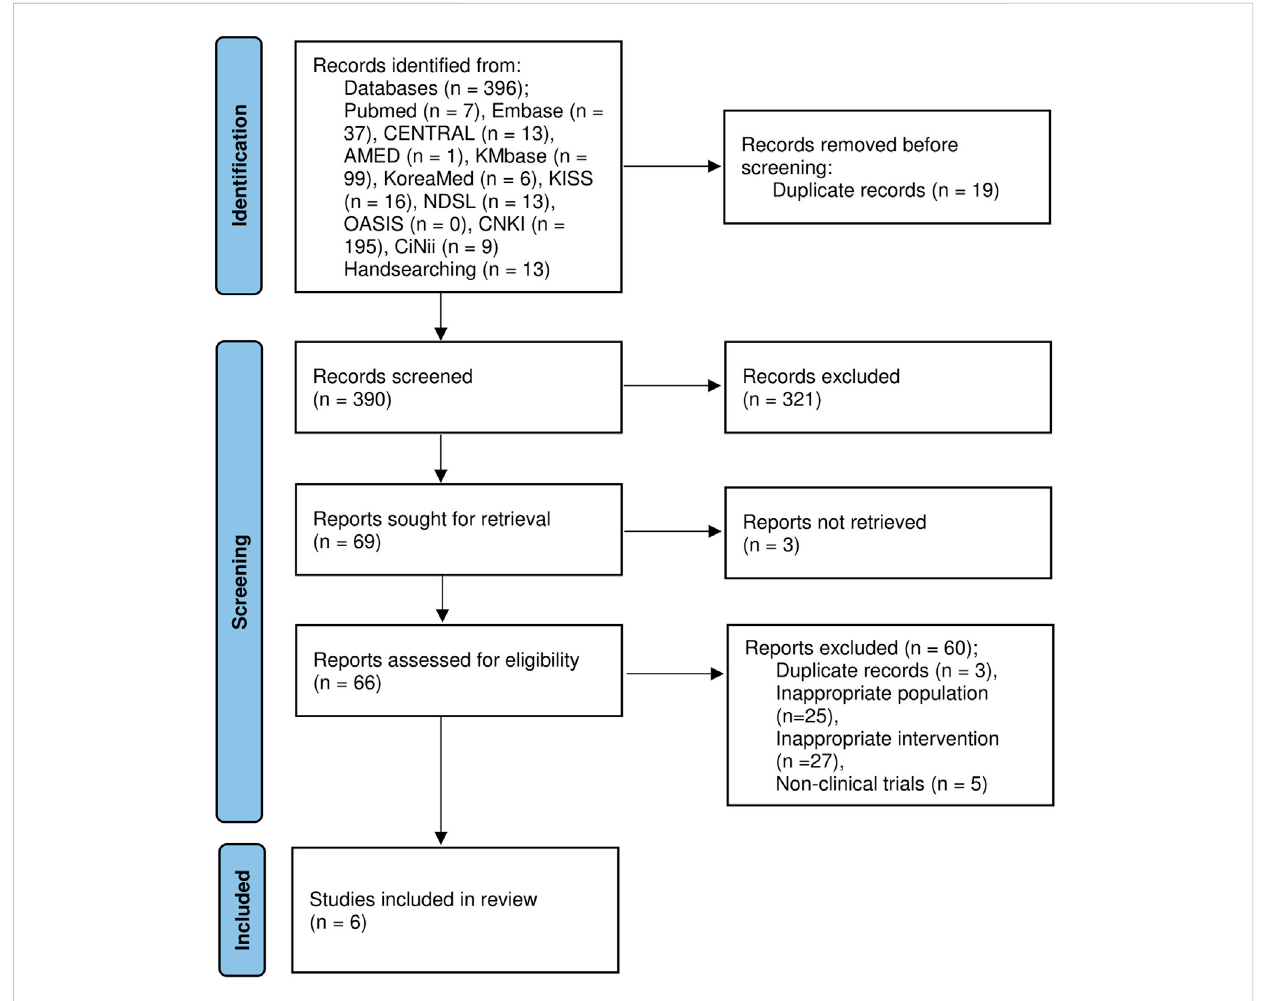
FIGURE 1 Flow chart of the literature